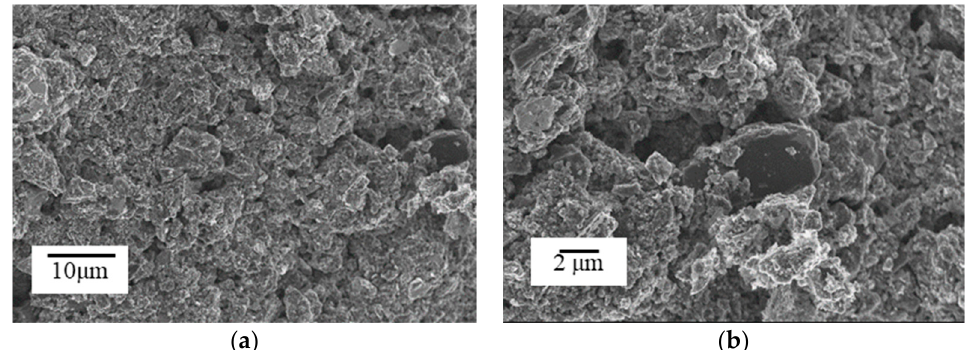
Figure 7. FESEM image of the biochar filler: ( a ) overview at magnification of 10 m; ( b ) magnification of 200 nm showing the granular aspect of biochar.